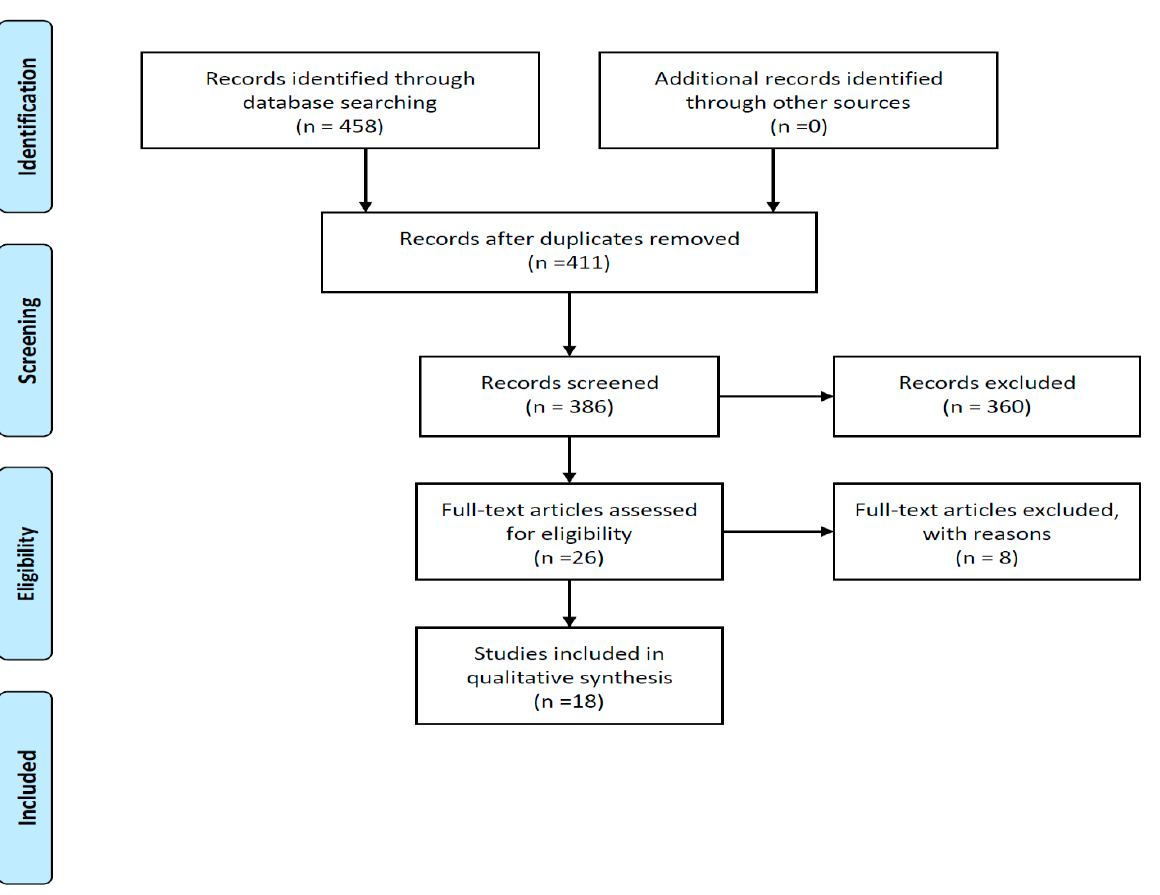
Table 1. Descriptive details of included studies.